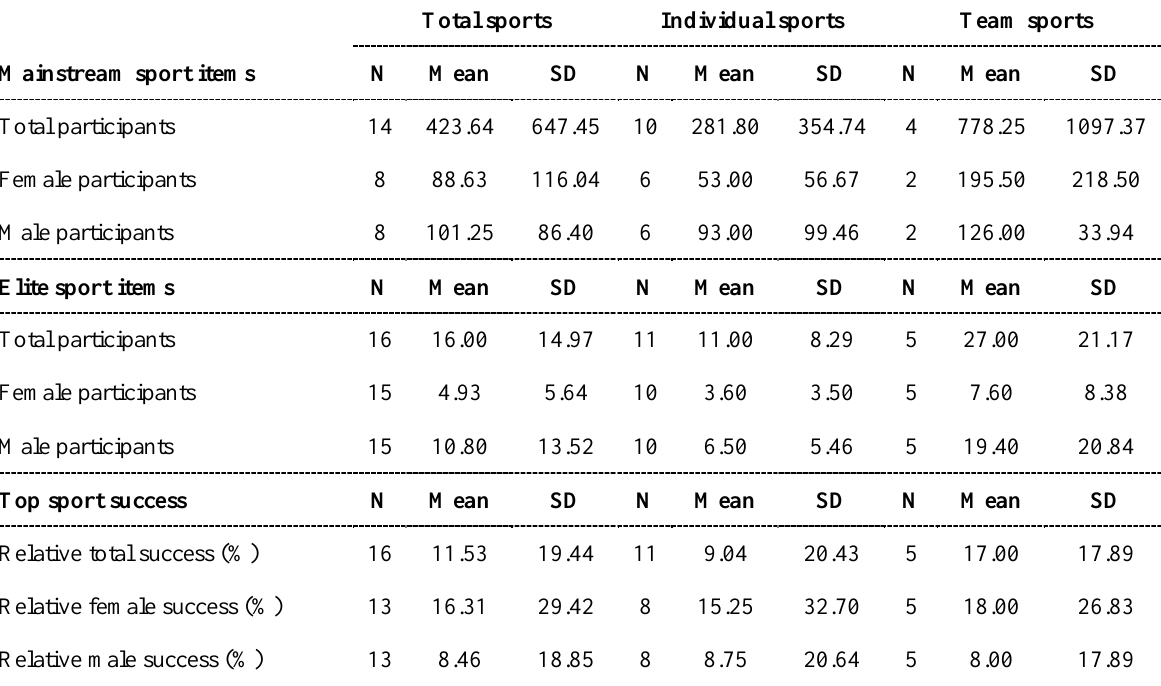
Descriptive data of questionnaire items, N = amount of sports with available data, mean and standard deviation